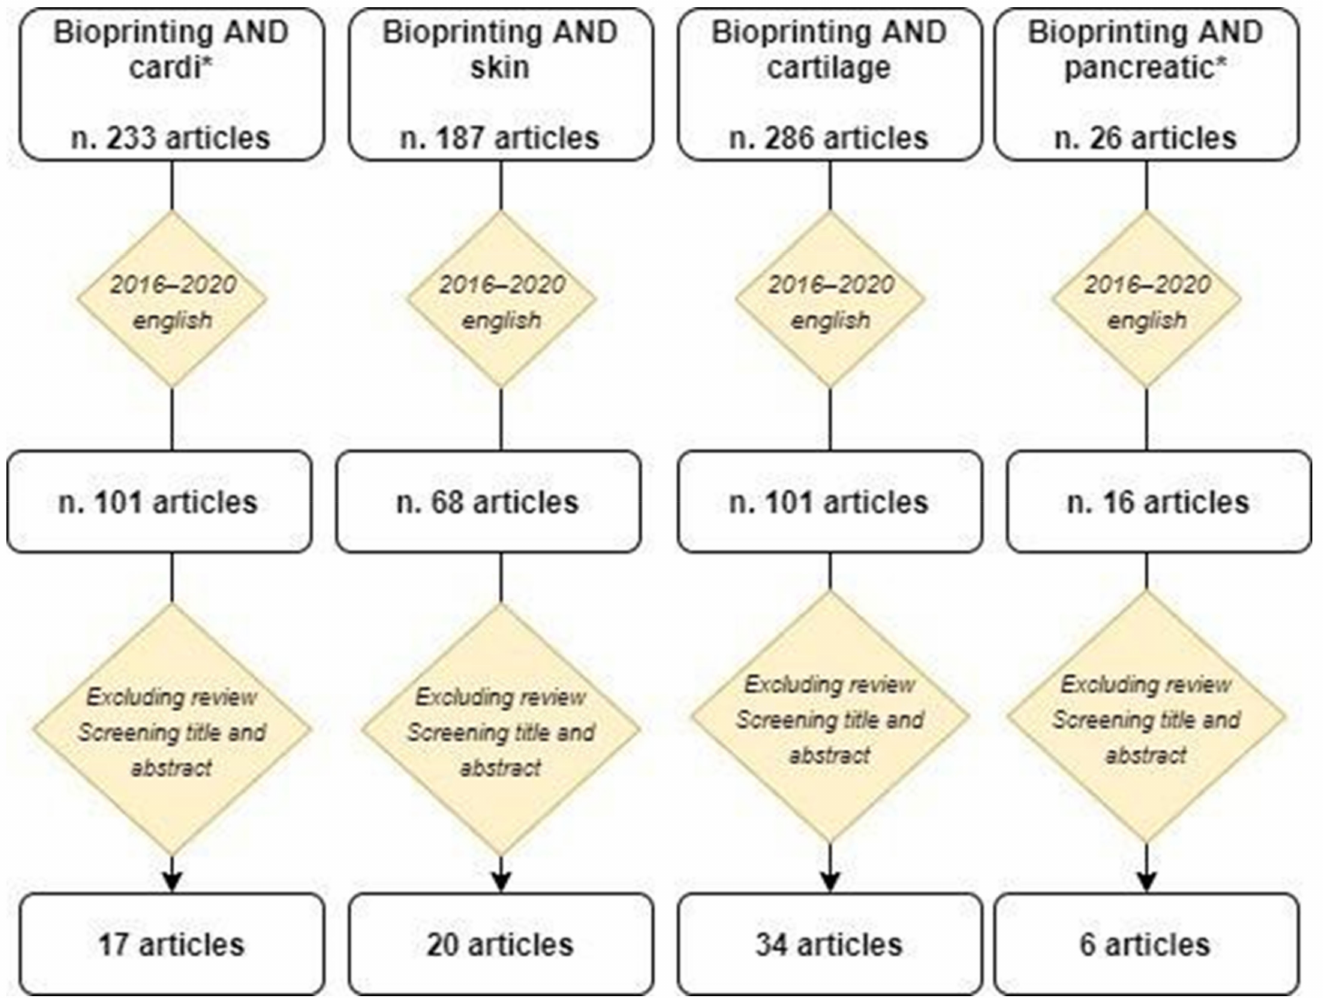
Figure 1. Article selection process. The selected articles by type of tissue are reported in Tables